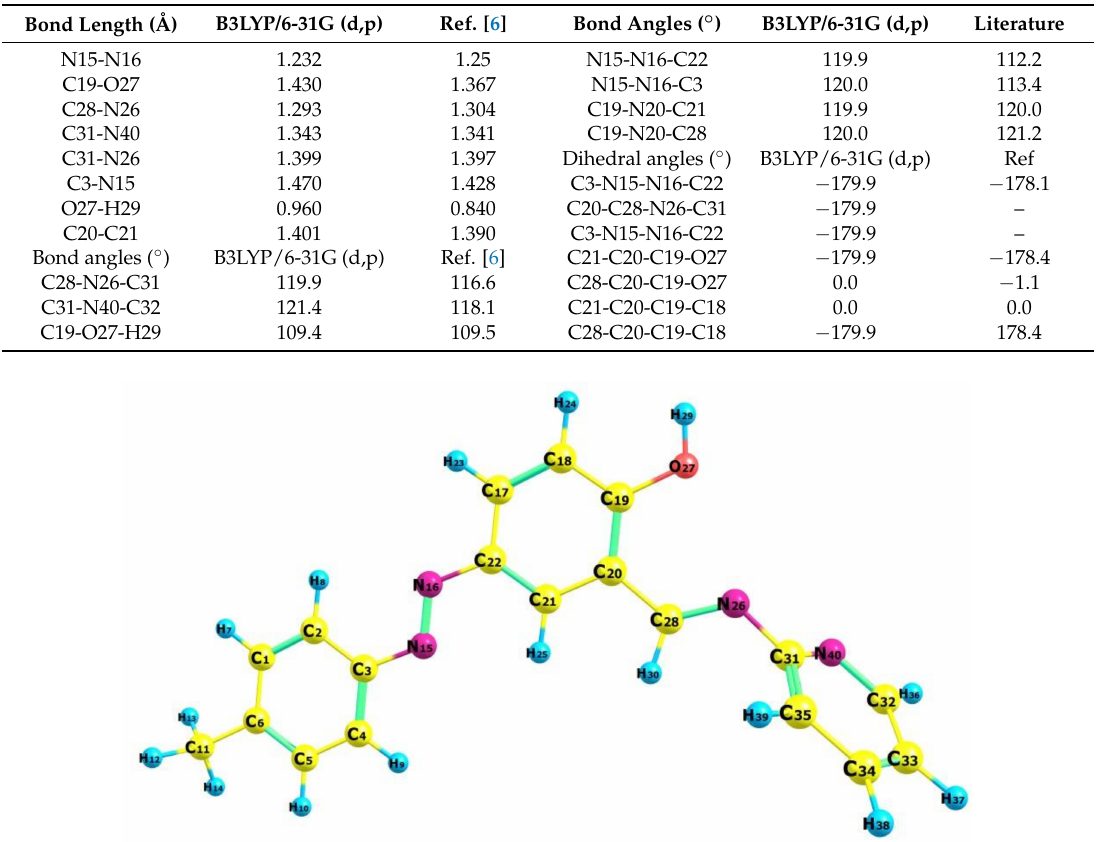
Figure 5. Optimized geometry of the ligand visualized using Chemcraft